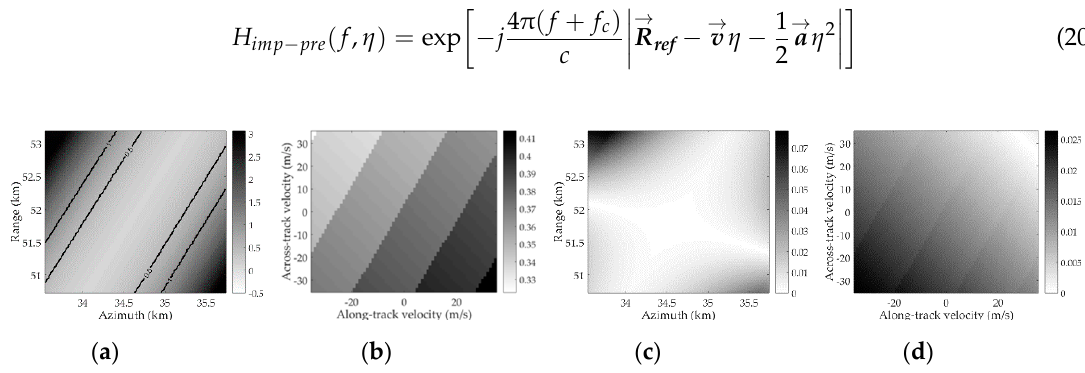
Figure 11. Effects of the µ 4 terms on phase error, and spatial and velocity variations with large acceleration. The unit of the contour maps is π /4: ( a ) phase error of the µ 4 term with different target locations; ( b ) phase error of the µ 4 term with different target velocities; ( c ) spatial variation of the µ 4 term; and ( d ) velocity variation of the µ 4 term.